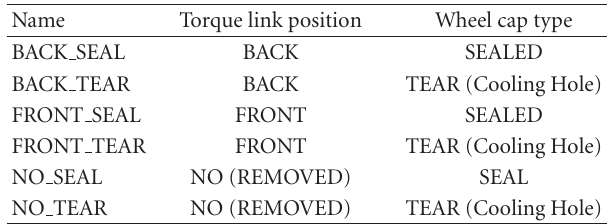
Table 2: Six LEG